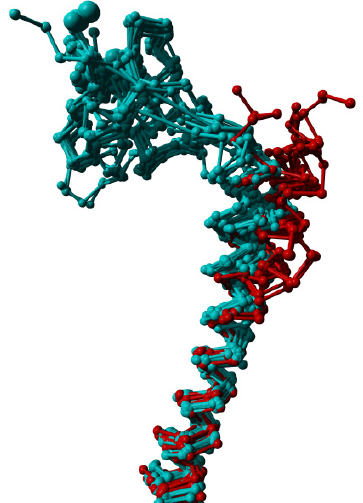
Figure 7. Helix I extracted from a structural alignment of 69 structures in YASARA’s [44] C α trace representation. The structures from which the N -terminal domain was removed (and sometimes also a small part of the extracellular end of this helix truncated), display an outward displacement of helix I away from the transmembrane helix bundle.